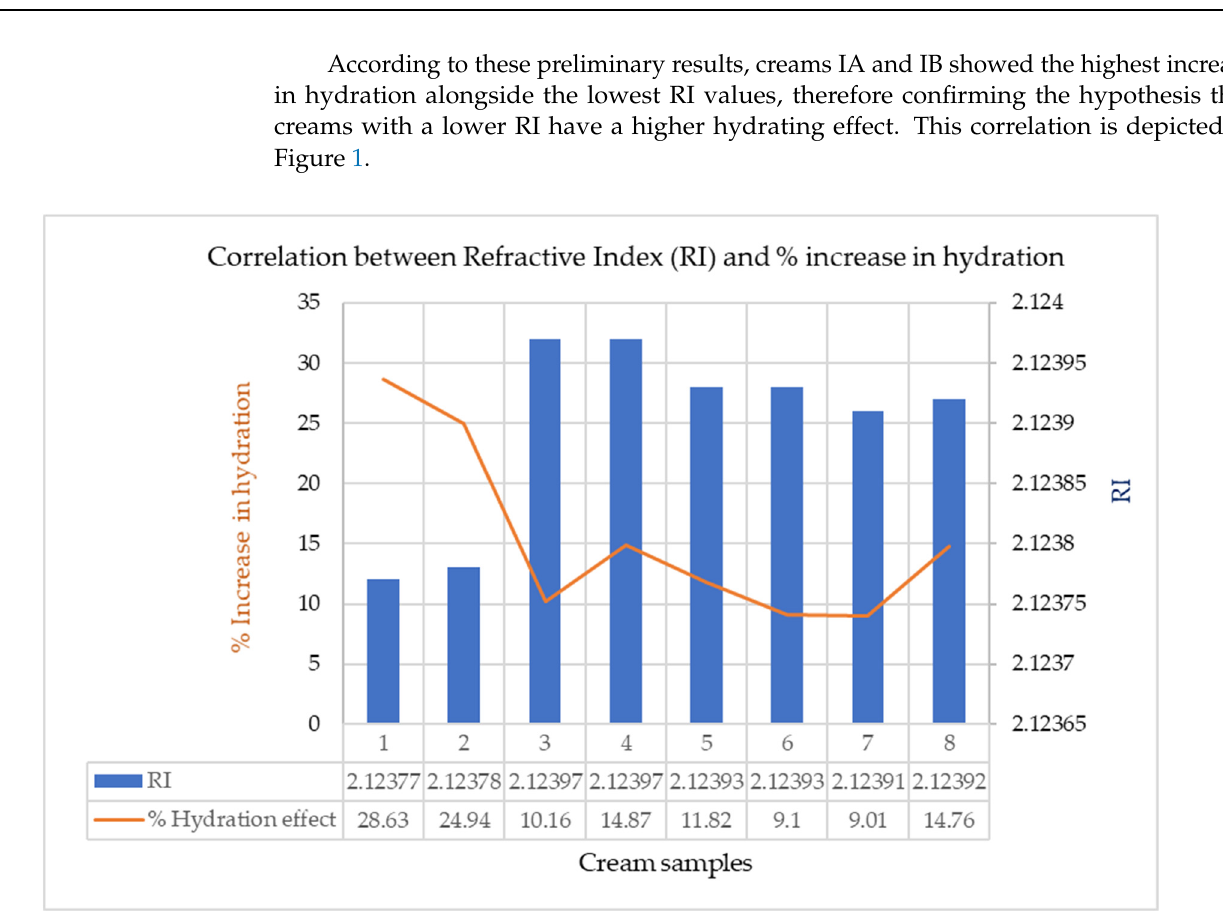
Figure 1. Relationships between RI and % increase in hydration. Cream samples (IA to IVB) are shown in numerical order of 1–8.